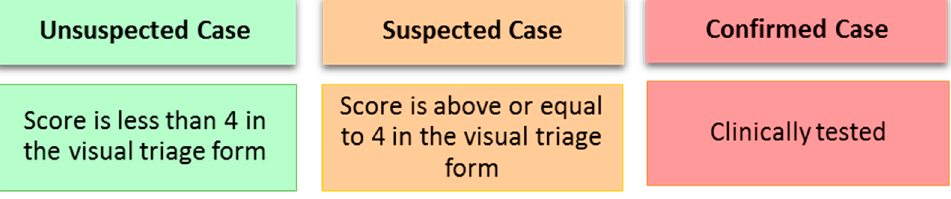
Figure 12. Classification criteria of COVID-19 for remote patients.